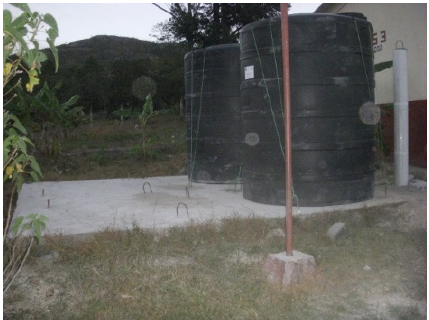
Figure 6. Water tanks in Corral de Piedras, La Paz, Honduras (Photo Credit: F. M. Tehrani, captured 2011).